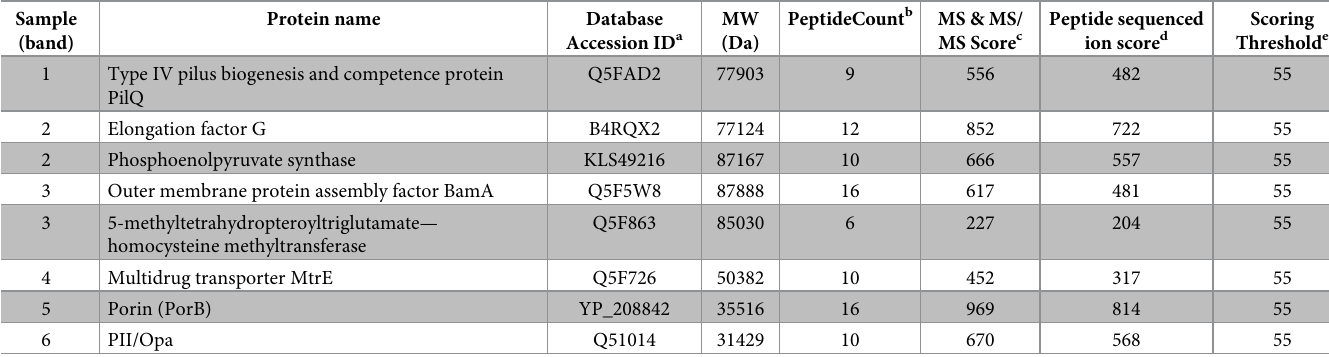
Table 1. Identification of protein bands recognized by 4CMenB antisera as determined by mass spectrometry. Sample